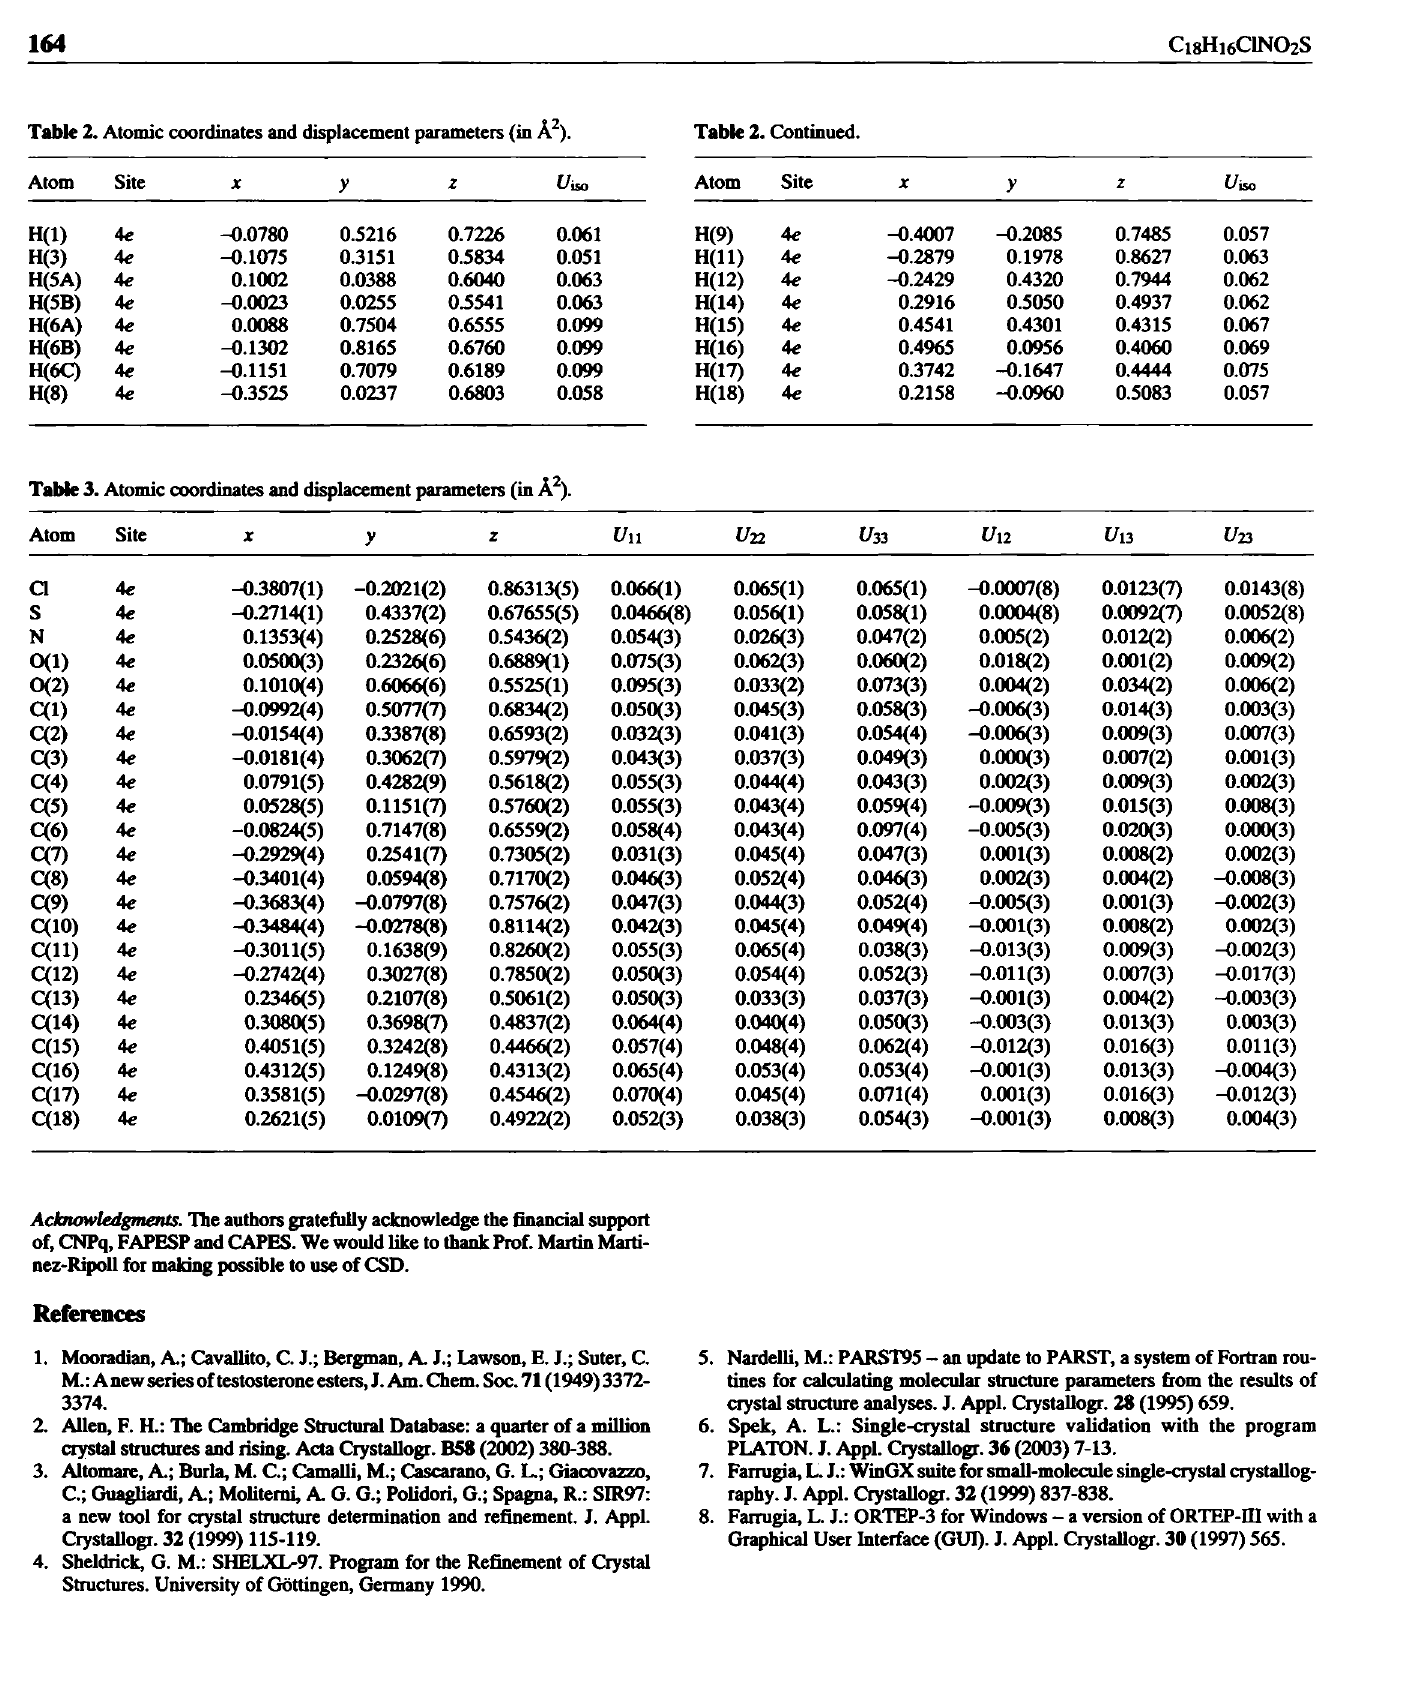
Table 2. Atomic coordinates and displacement parameters (in A 2 ). Table 2. Continued.